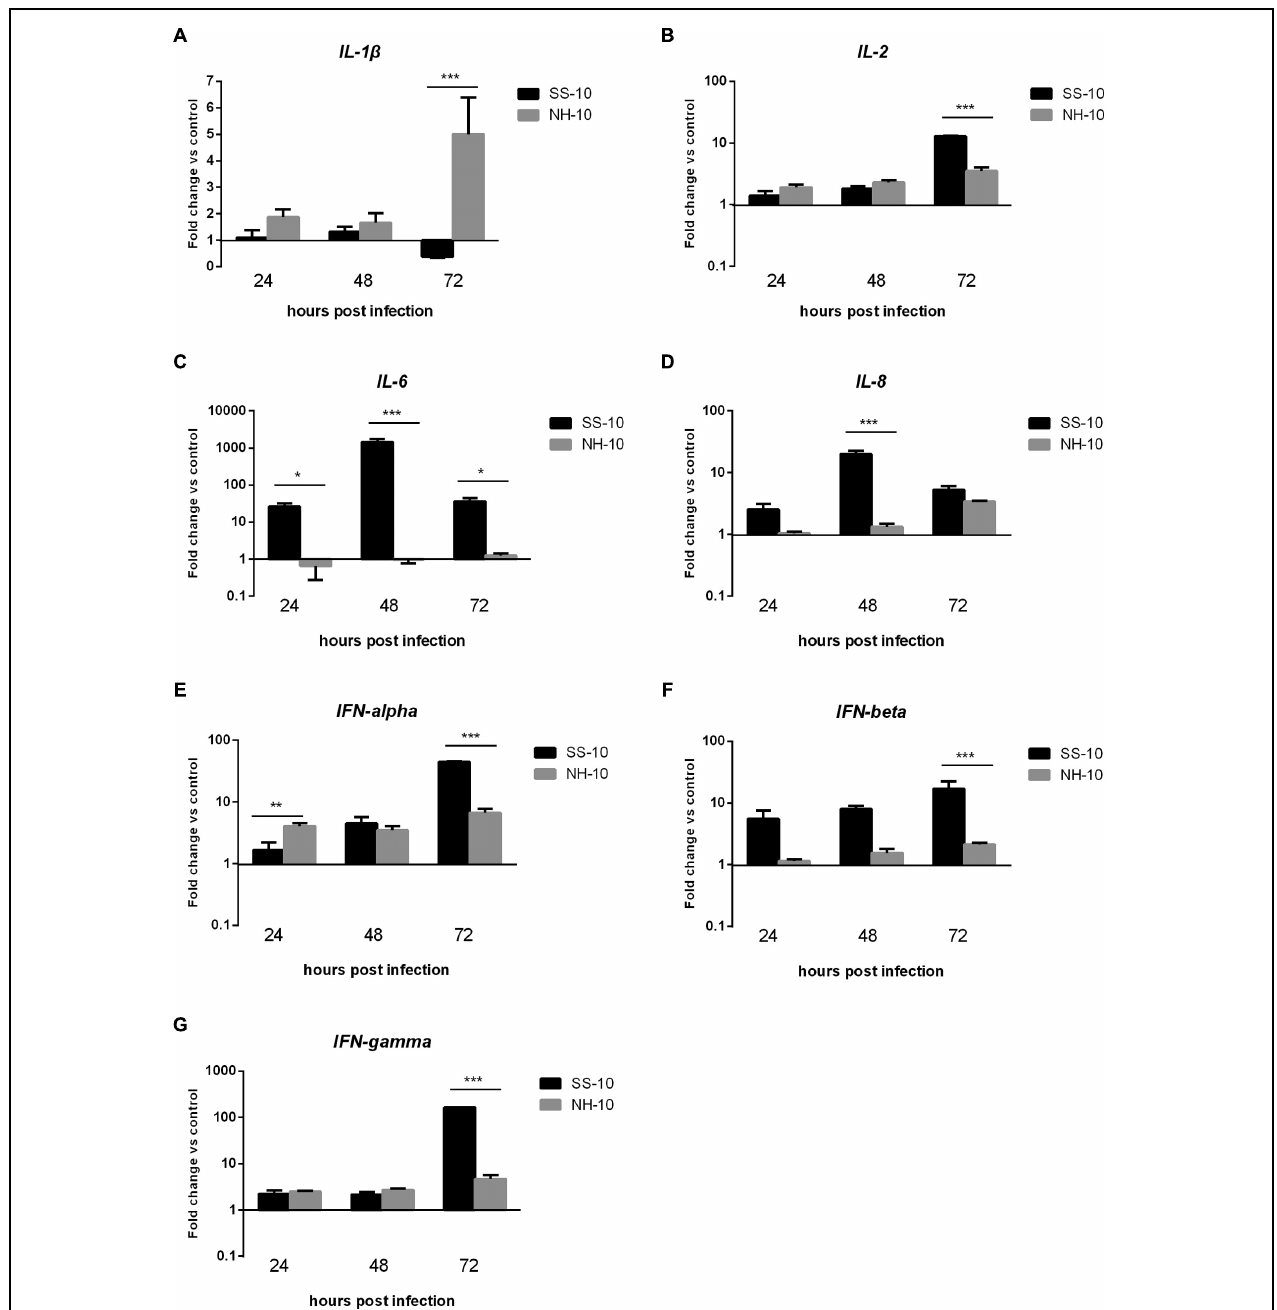
FIGURE 5 | Fold change expression of cytokines in the thymuses of infected ducks in response to SS-10 and NH-10. (A) IL-1 β , (B) IL-2 , (C) IL-6 , (D) IL-8 , (E) IFN-alpha , (F) IFN-beta , (G) IFN-gamma . The Y -axis represents the fold change in target gene expression in the experimental group relative to those in the control group and presented as the mean values ± standard deviation ( n = 3). Significance is analyzed with two-way ANOVAs between SS-10 group and NH-10 group at the same time points ( ∗ p < 0.05, ∗∗ p < 0.01, ∗∗∗ p < 0.001). Error bars indicate standard